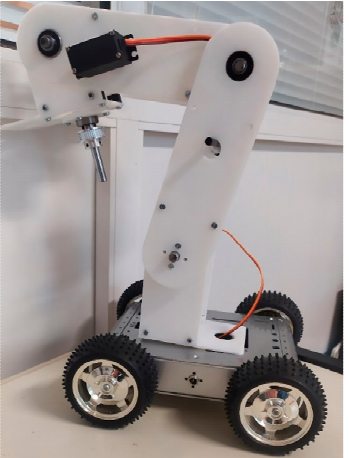
Figure 1. Robotic System Overview.